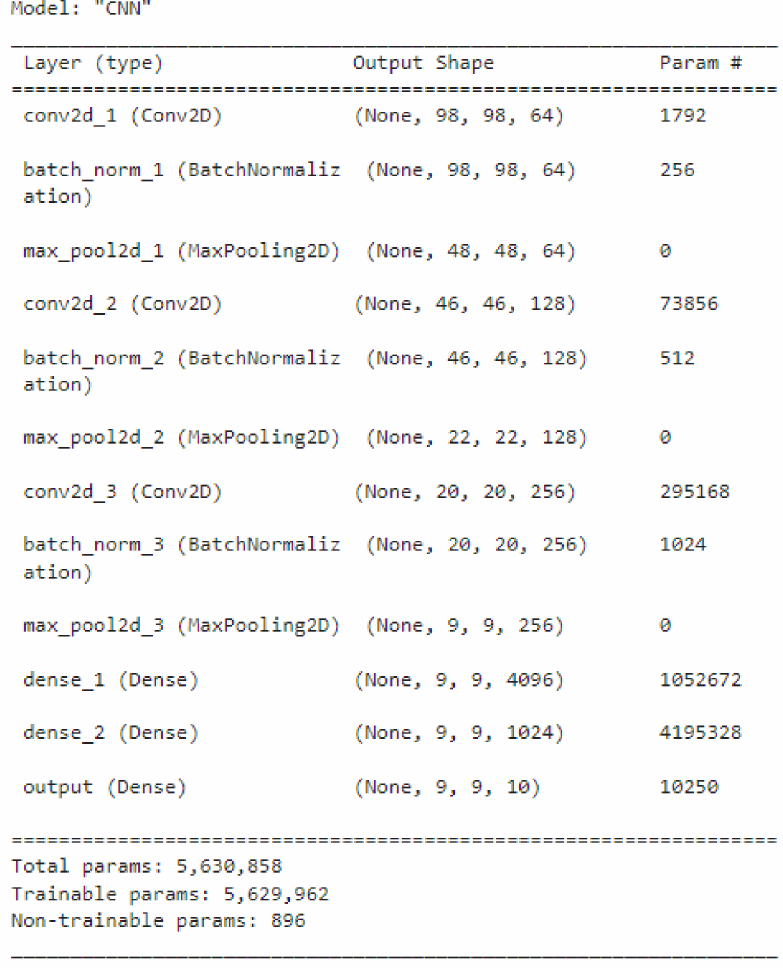
Figure 12. Example of a simple CNN